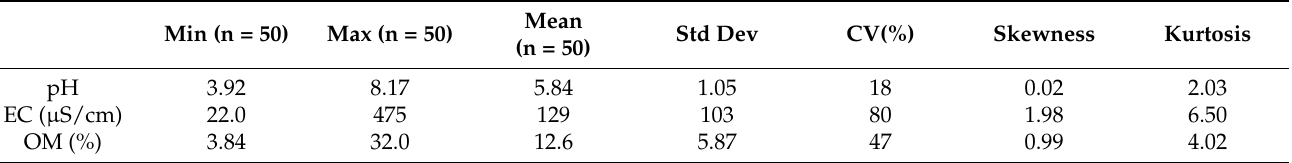
Table 4. Descriptive statistics of soil physicochemical properties—pH, electrical conductivity (EC), and organic matter (OM).